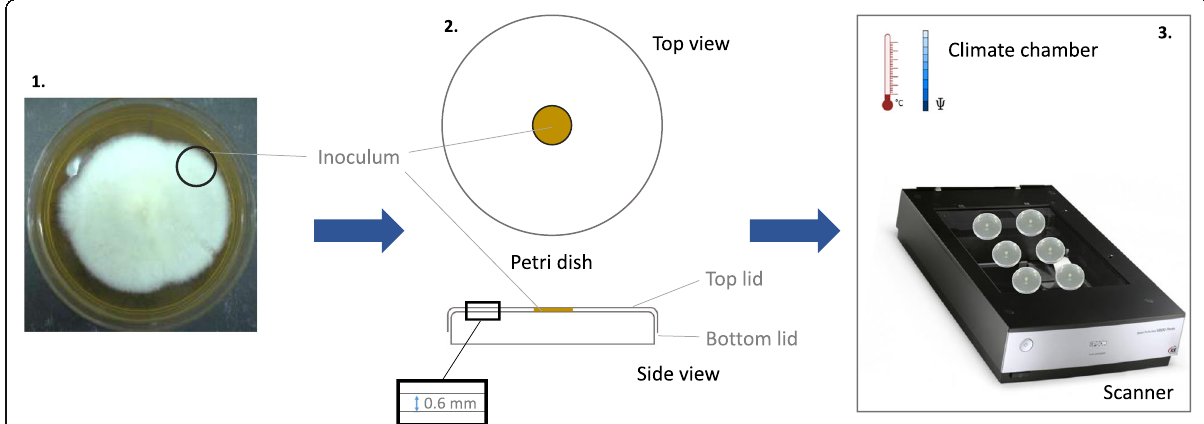
Fig. 1 Schematic representation of the experimental set-up. A disc-shaped inoculum is taken from the periphery of the mother culture (1) and positioned at the centre of the bottom lid of a Petri dish (2). The top lid of the Petri dish is positioned on top of the bottom lid, as such restricting the height between top and bottom lids to 0.6mm (2). Then, the Petri dishes are transferred to the flatbed scanner in a climate chamber